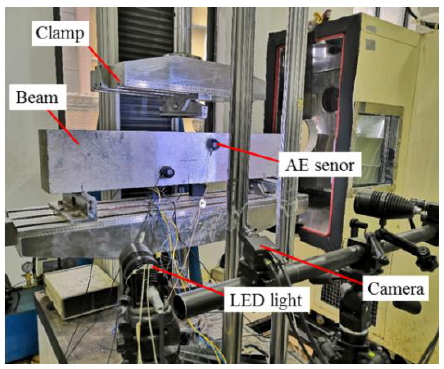
Figure 3. Experimental setup.